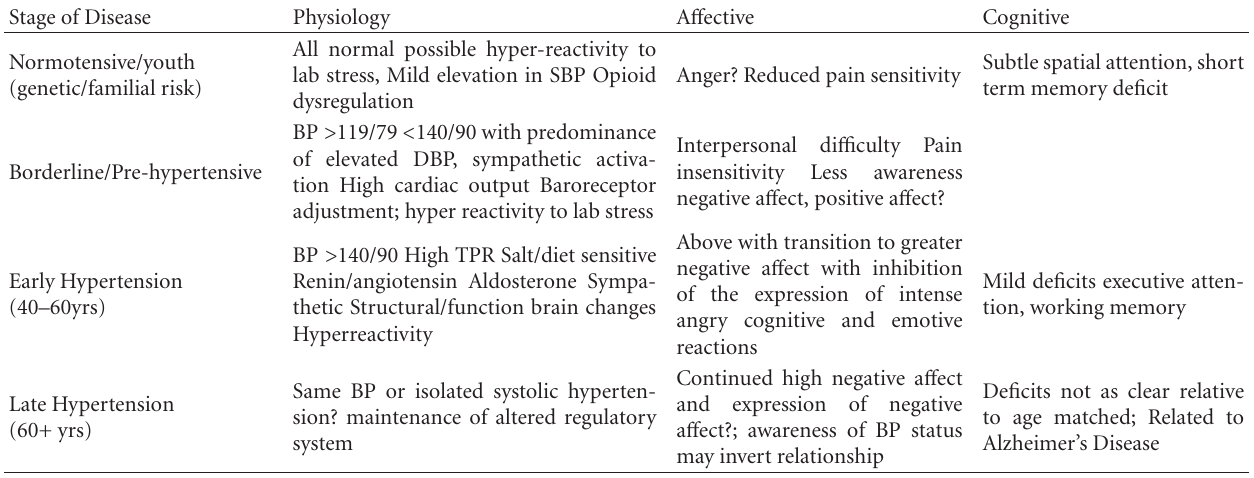
Table 1: Diagrammatic illustration of integrated study of the natural history of